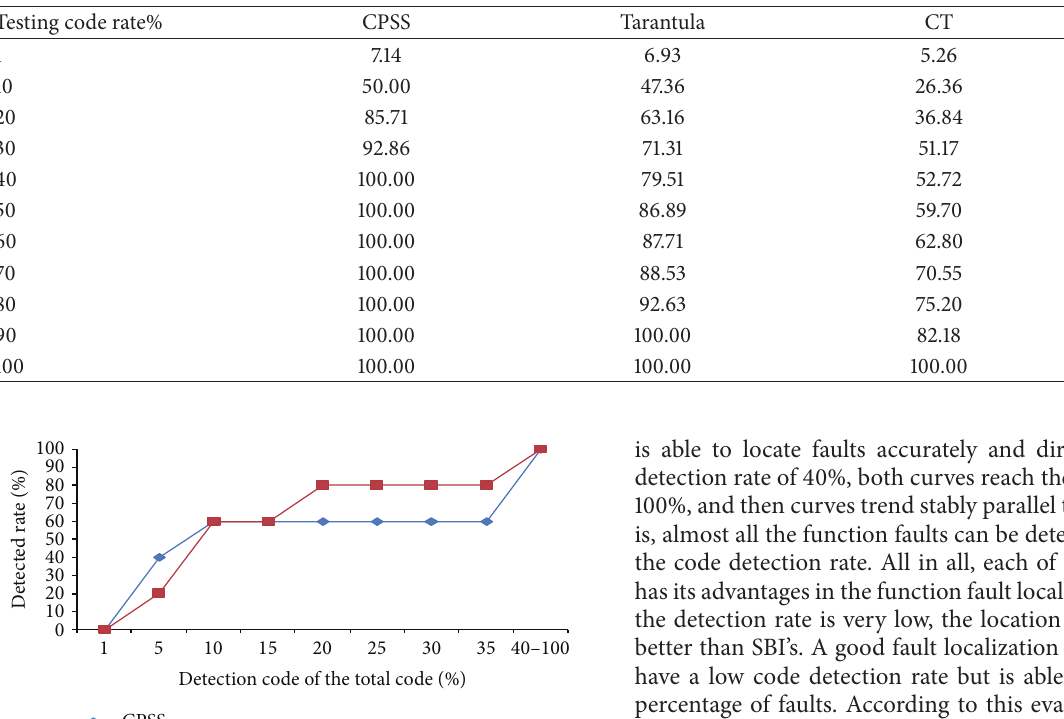
Table 2: Within the scope of each code to detect the error ratio.